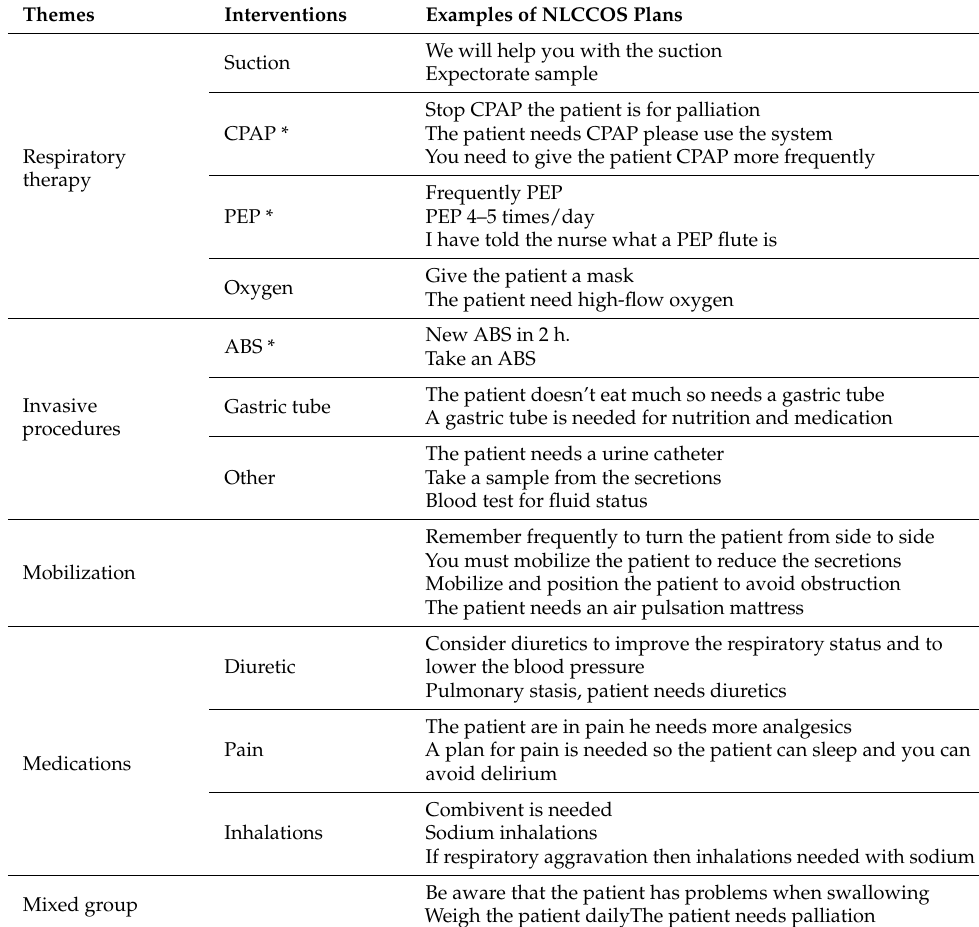
Table 3. Interventions provided by the NLCCOS and examples of plans made for future